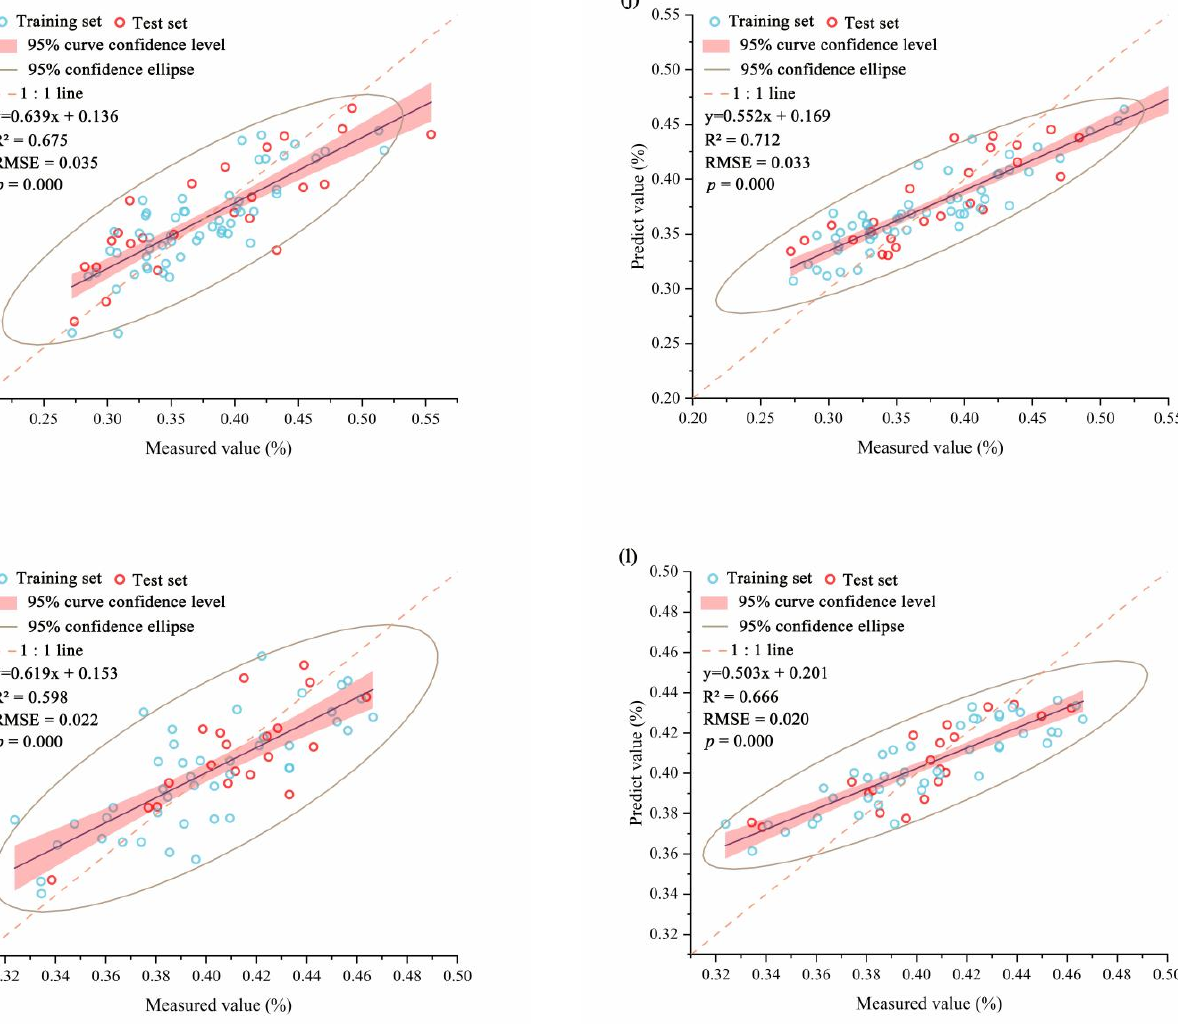
Figure 6. Estimated LWC of bamboo leaves in different damage states: ( a ) entire sample, MLR model; ( b ) entire sample, RF model; ( c ) H-MLR; ( d ) H-RFR; ( e ) Mi-MLR; ( f ) Mi-RFR; ( g ) Mo-MLR; ( h ) Mo-RFR; ( i ) S-MLR; ( j ) S-RFR; ( k ) O-MLR; ( l ) O-RFR. Multiple linear regression (MLR), random forest regression (RFR).